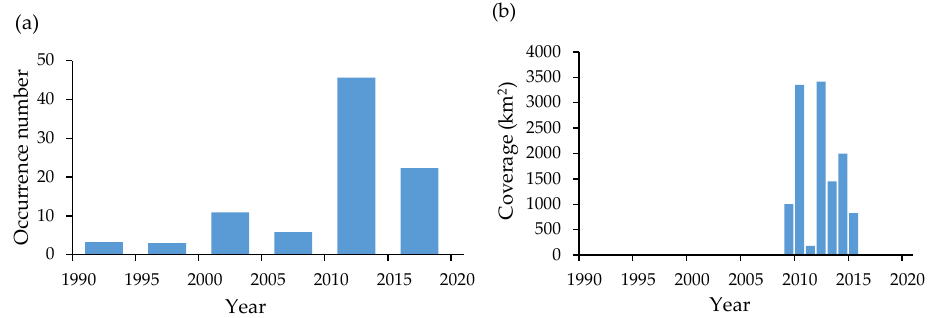
Figure 12. The occurrence number of red tide ( a ) and the A. anophagefferens coverage during the brown tide period ( b ) from 1990 to